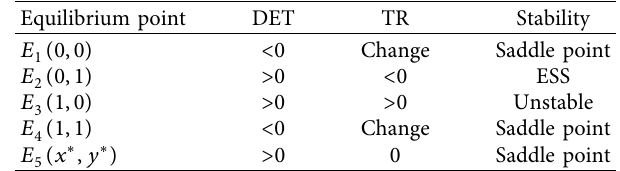
Table 3: Stability analysis of strategy system ( a ) of the government and enterprise.